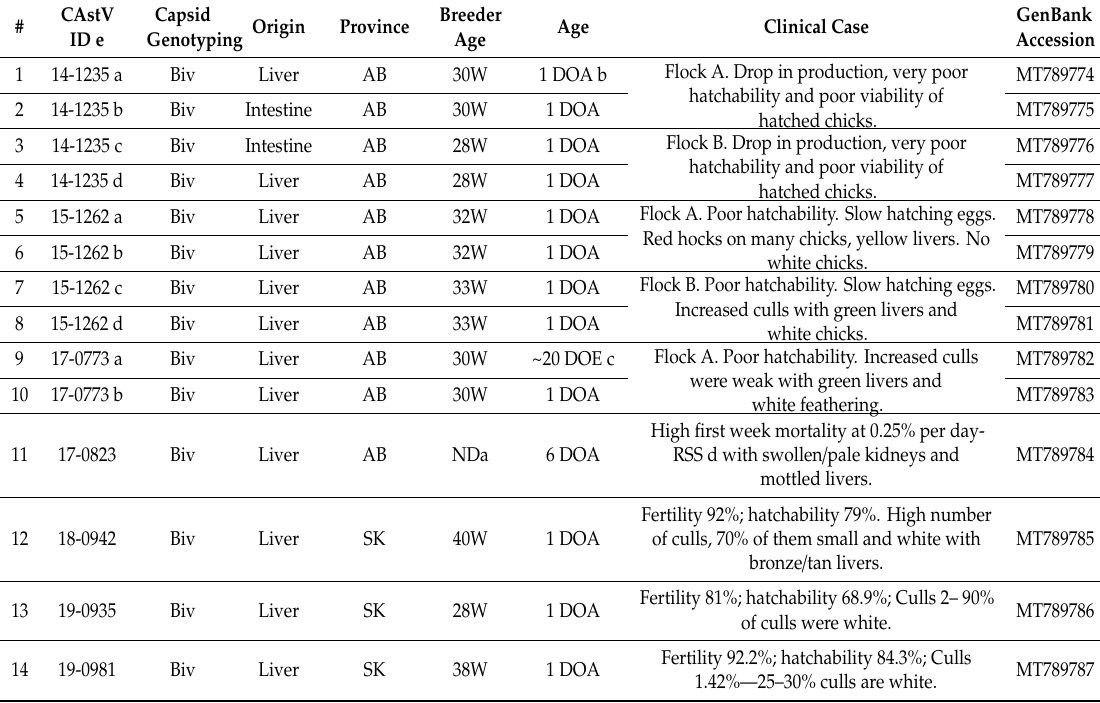
Table 1. List and classification of 14 CAstV isolates deposited in GenBank and background information.